Question: In a single sentence, describe what this figure presents.
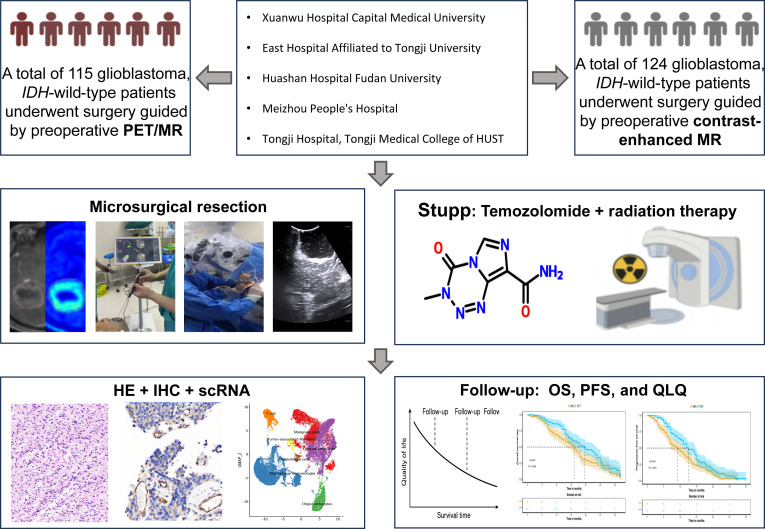
Answer: Workflow of the current study. This multicenter prospective study enrolled a total of 239 patients with glioblastoma, IDH -wild-type, including 124 patients who underwent surgery guided by preoperative contrast-enhanced (CE) MRI and 115 patients guided by preoperative 18 F-fluoroethyltyrosine (FET) positron emission tomography (PET). Participating centers included Xuanwu Hospital, Capital Medical University, Huashan Hospital, Fudan University, The East Hospital Affiliated to Tongji University, Tongji Hospital, Tongji Medical College of HUST, and Meizhou People’s Hospital. All patients underwent microsurgical resection, followed by standard Stupp regimen (concurrent radiotherapy with temozolomide followed by adjuvant temozolomide) and were followed every 3 months with MRI. Follow-up protocols were harmonized across centers. Intraoperative assessments included ultrasound imaging and pathological sampling. Postoperative samples were subjected to hematoxylin and eosin (HE), immunohistochemistry (IHC), and single-cell RNA sequencing (scRNA-seq) for molecular and cellular characterization. Patients were followed up for up to 12 months with both survival (overall survival [OS] and progression-free survival [PFS]) and quality of life (QoL) assessments. QoL was measured using the European Organisation for Research and Treatment of Cancer (EORTC) QoL Questionnaire-Core 30 (QLQ-C30) and QoL Questionnaire-Brain Neoplasm Module (QLQ-BN20) at 3, 6, 9, and 12 months postoperatively. Kaplan–Meier (KM) survival curves indicated significantly better OS and PFS outcomes in the 18 F-FET PET-guided group compared to the CE MRI-guided group. UMAP, Uniform Manifold Approximation and Projection.